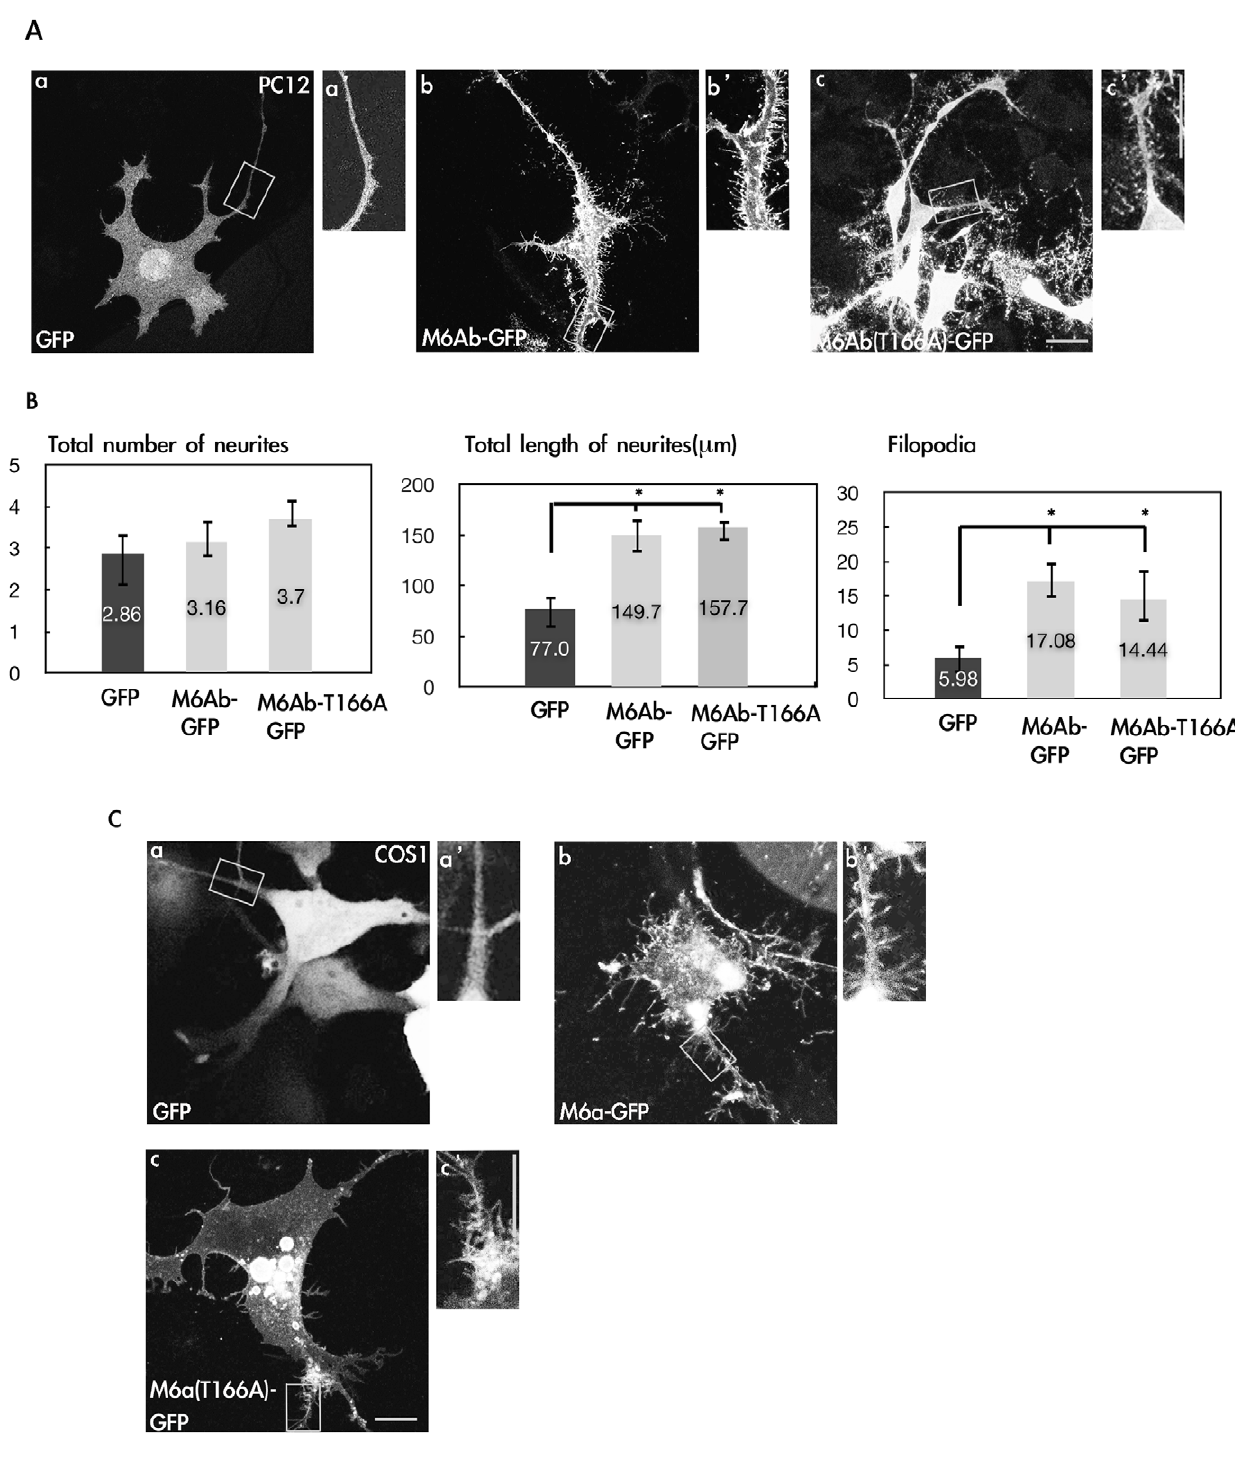
Figure 2. Overexpression of zM6Ab can induce neurite outgrowth and filopodia in PC12 and COS-1 cells. (A) PC12 cells were transfected with the control pcDNA3-GFP or pcDNA3-M6Ab-GFP or pcDNA3-M6Ab-T166A-GFP plasmids. Twenty-four hours after transfection, cells were treated with nerve growth factor (NGF) (100 ng/ml) for 2 days. Cells were then fixed, and images were taken with a Zeiss LSM510 laser scanning confocal microscope. The insets are the 2 6 magnified images of the boxed areas. (B) Quantification of the total number of neurites, total length of neurites, and filopodium-like processes in a 20- m m neurite length. * indicates a significant difference compared with the respective control of GFP (P , 0.05). (C) COS-1 cells were transfected with the control pcDNA3-GFP or pcDNA-M6Ab-GFP or pcDNA3-M6Ab-T166A-GFP plasmids. Cells were fixed, and images were taken with a Zeiss LSM510 laser scanning confocal microscope. Scale bars, 10 m m.